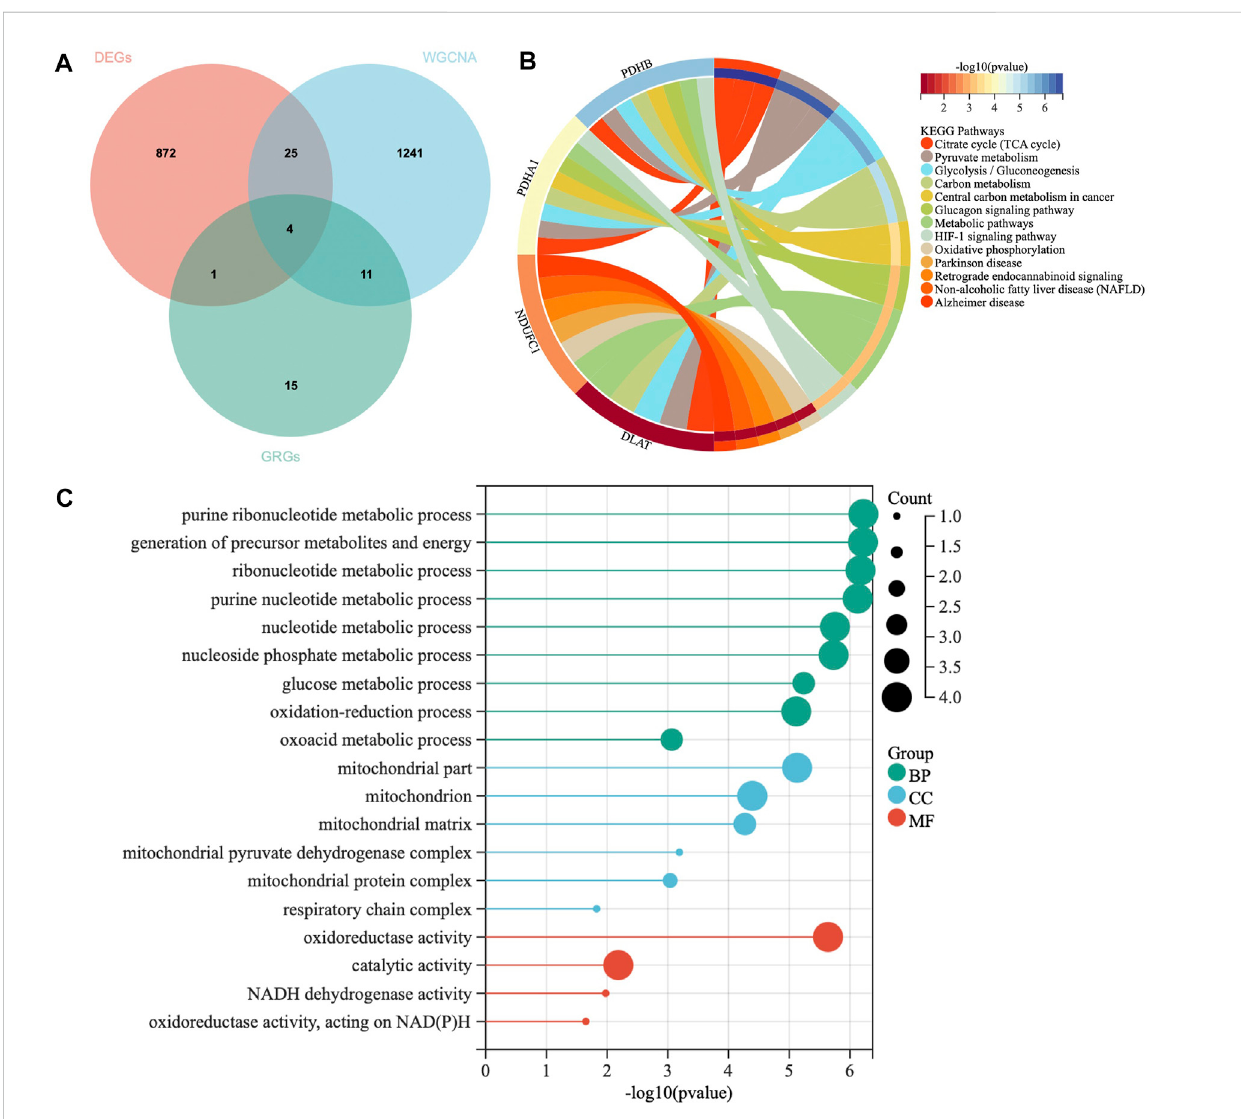
FIGURE 4 Identi fi cation of hub genes and Functional enrichment analysis. (A) The Venn diagram of genes among differentially expressed genes (DEGs) list, WGCNA and cuproptosis related genes (CRGs). (B) Kyoto Encyclopedia of Genes and Genomes (KEGG) enrichment analysis for hub genes. (C) Gene Ontology (GO) enrichment analysis for hub genes, including biological processes (BP), cellular components (CC) and molecular functions